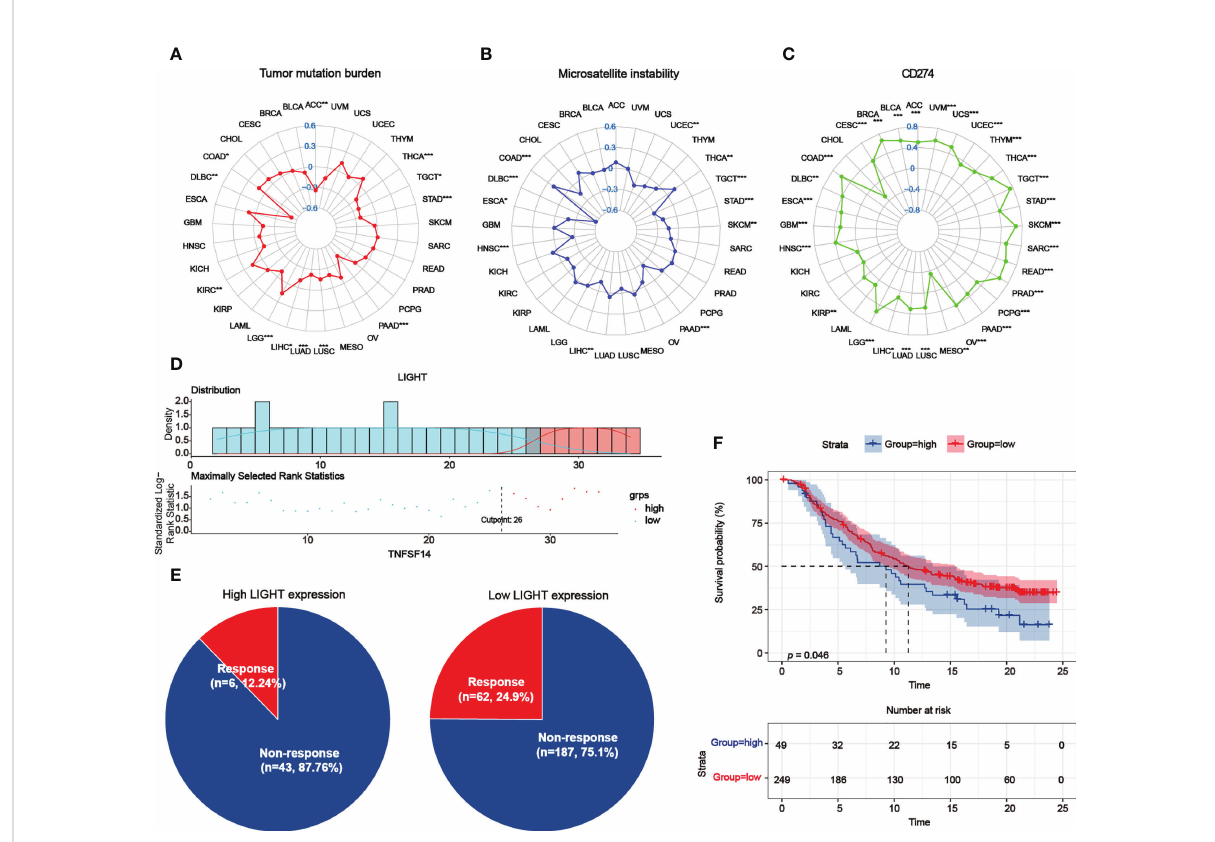
FIGURE 10 Role of LIGHT expression in response to ICB therapy. (A – C) The association between LIGHT expression and TMB (A) , MSI (B) , and CD274 expression levels (C) was shown by radar graphs. The correlation coef fi cient is shown by the dots in radar charts. (D) The “ survminer ” package ’ s optimal cutoff values for the low- or high-LIGHT expression group. (E) The percentage of patients with low or high LIGHT expression that responded to PD-L1 block immunotherapy was depicted in pie plots. (F) The Kaplan-Meier curve in the anti-PD-L1 immunotherapy cohort indicated the survival of the patient groups with high and low LIGHT expression (IMvigor210 dataset; P = 0.046, Log-rank